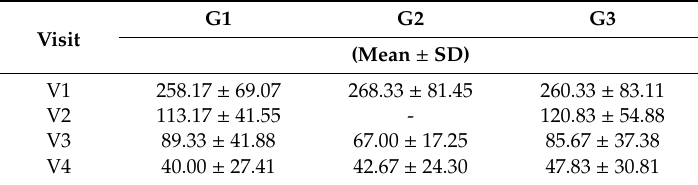
Table 2. IBS-SS for patients in all